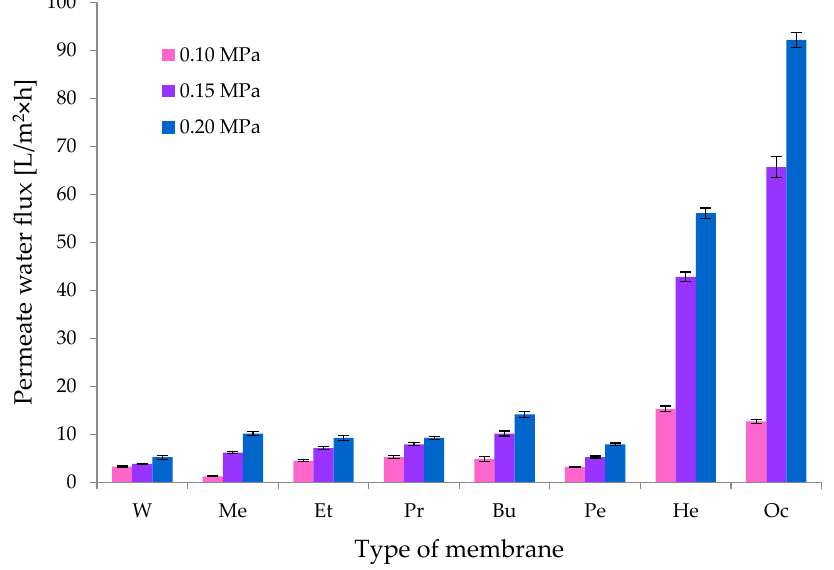
Figure 11. Water flux for the obtained cellulose membranes.